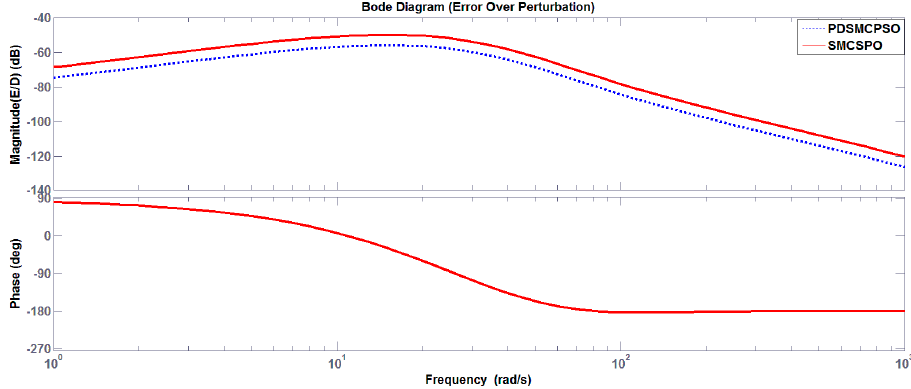
Figure 5. Bode plot of error over perturbation.